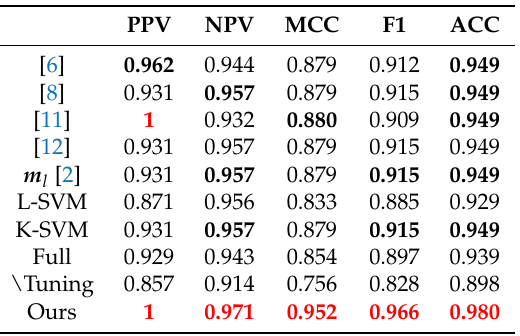
Table 3. Performance of actual sepsis data classification. The red bold is the best performance of each evaluation. The black bold is the second best performance. PPV NPV